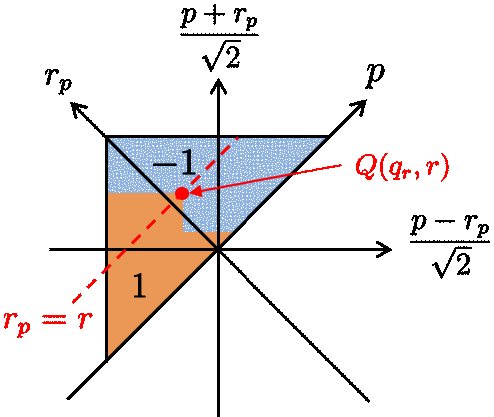
Figure 10. Magnetization boundary Q on a line r p = r